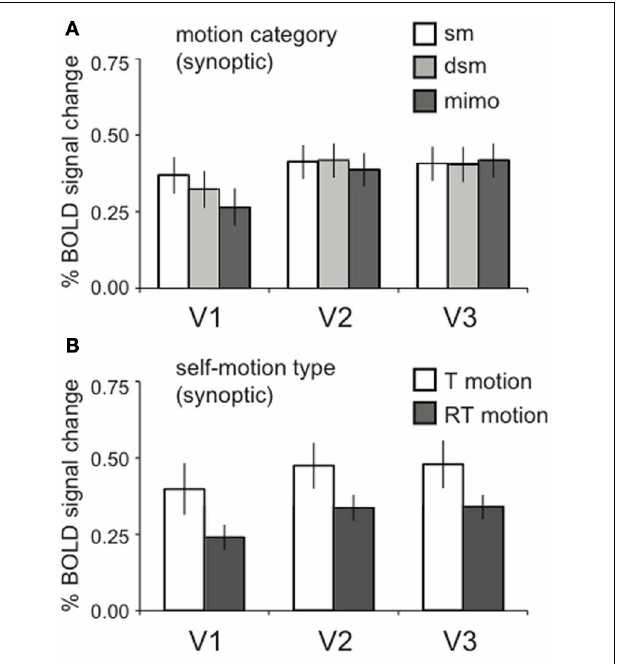
FIGURE 4 | Lower visual areas response to motion energy. (A) The averaged BOLD response across motion category dimension, for synoptic presentation. Within V1, V2, and V3, there was no response difference between motion categories [RM ANOVA, V1, V2, V3 all F ( 2 , 22 ) < 2 . 07; p > 0 . 05]. (B) The averaged BOLD response for the two self-motion types (RT motion, T motion), for synoptic presentation. There was no effect of self-motion type RM ANOVA, V1, V2, V3: all [ F ( 1 , 11 ) < 4 . 42, p > 0 . 05], though a trend for a larger response to T motion can be observed. Error bars represent